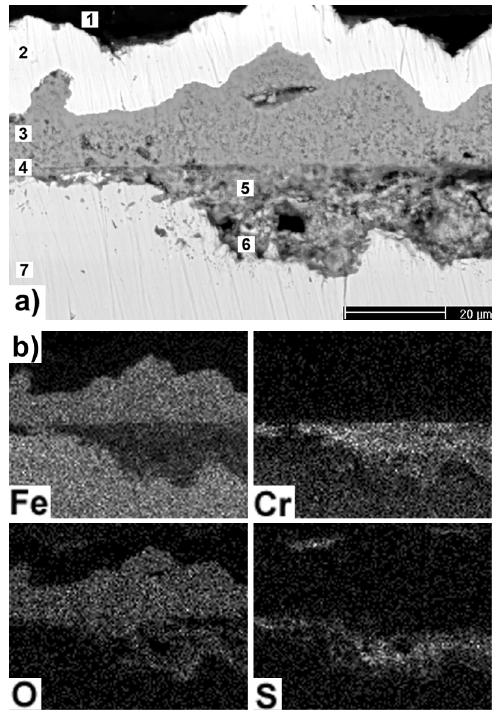
Figure 16. Cross-section of uncoated P91 after 336 hours at 883 K in N 2 (cid:3) 100 ppmv HCl (cid:3) 100 ppmv SO (cid:3) 2 10 % H 2 O (cid:3) 8:4 % O 2 . a) BSE-image. 1) Mounting. 2) Nickel coating. 3) Fe 2 O 3 . 4) Original surface. 5) Cr-rich layer. 6) Layer in which S can be found. 7) Substrate. b) Corresponding elemental maps for Fe, Cr, O and